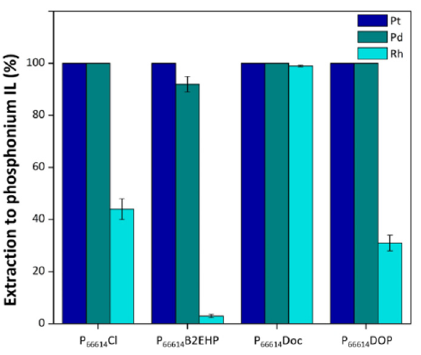
Figure 4. Extraction efficiencies (%) of PGMs to pure (undiluted) phosphonium ILs.